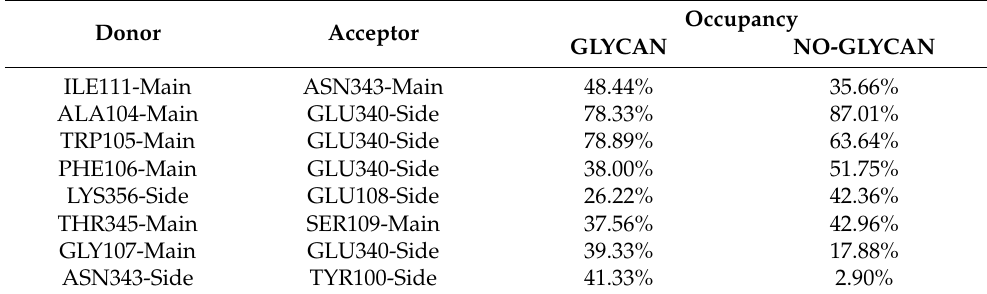
Occupancy GLYCAN NO-GLYCAN